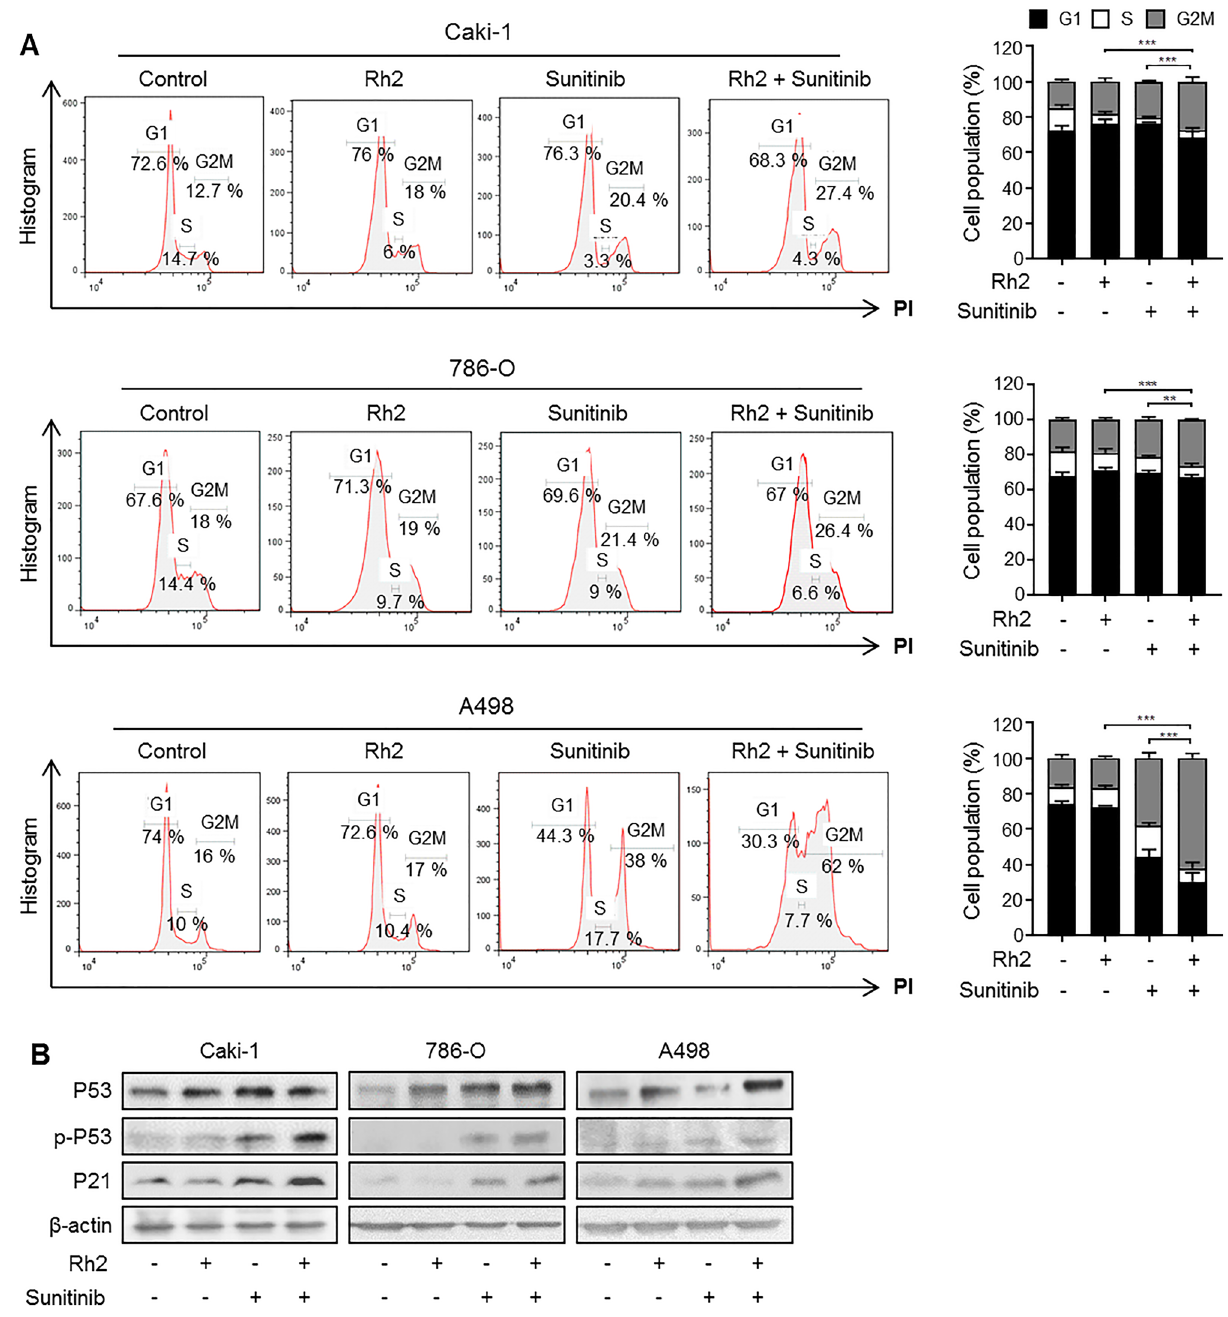
Figure 2. Combination treatment of sunitinib and ginsenoside increases cell cycle arrest in ccRCC cell lines. ( A ) Cells were treated with ginsenoside Rh2 (10 μM) and sunitinib (10 μM) and analyzed using propidium iodide staining detected by flow cytometry. Quantification of the cell cycle was performed. Perform at least three biological repeats (n = 3). ( B ) Protein levels of p-P53 (p-S15), P53, and P21 were detected by western blot. β-actin was used as a loading control. (n =